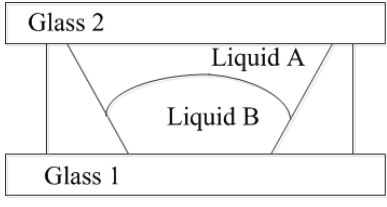
Figure 7. The compensated structure of the liquid lens featuring a 9× zoom ratio.